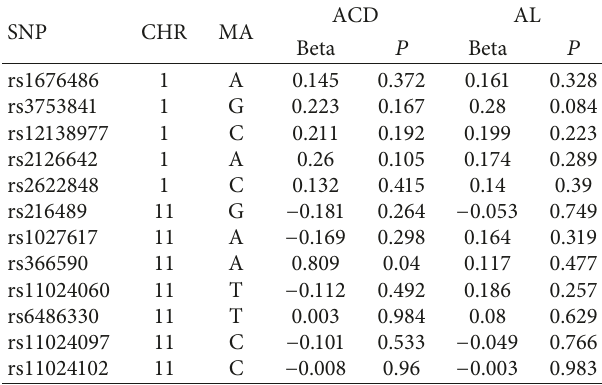
Chi-square tests and logistic regression were used. Table 6: Association results of 12 SNPs with axial length and anterior chamber